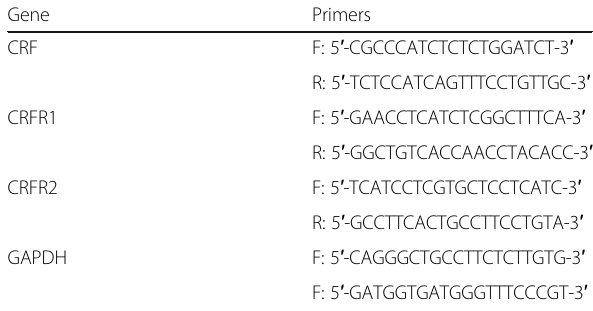
CRF , corticotropin-releasing factor; CRFR1 , corticotropin-releasing factor receptor 1; CRFR2 , corticotropin-releasing factor receptor 2; GAPDH , glyceraldehyde-3-phosphate